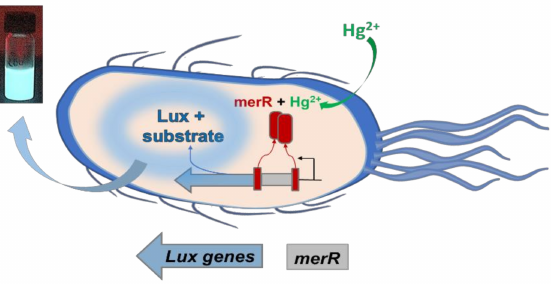
Figure 1. Scheme of the Hg 2+ recognition mechanism performed by the engineered E. coli sensor cells.